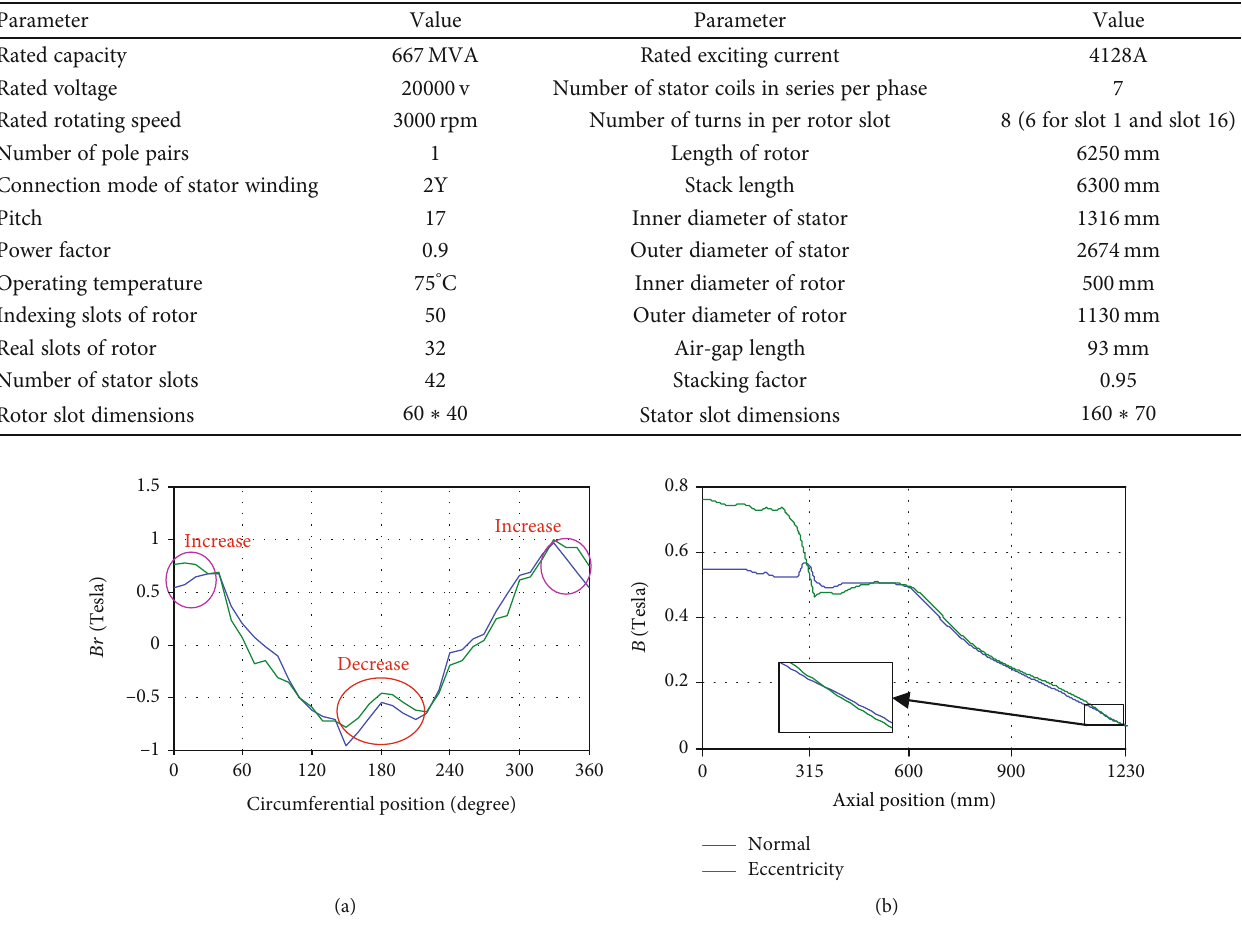
Figure 3: MFD variation: (a) circumferential distribution and (b) axial